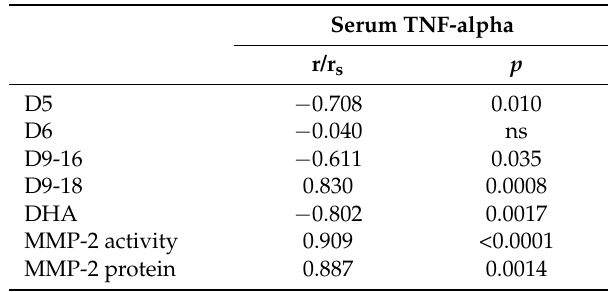
Table 2. Correlation between serum levels of TNF-alpha versus liver desaturase, DHA and MMPs. Serum TNF-alpha